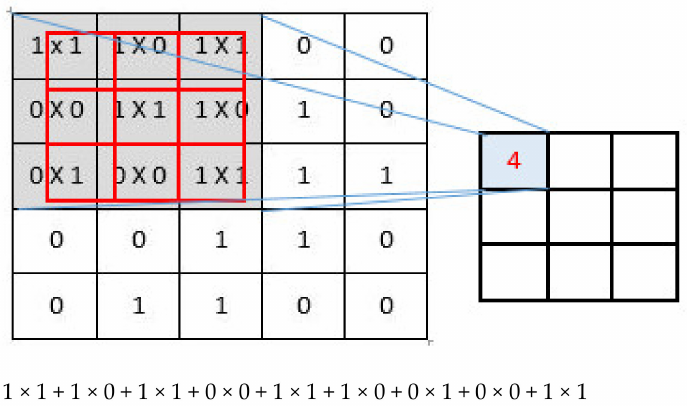
Figure 6. First step of convolution [8].